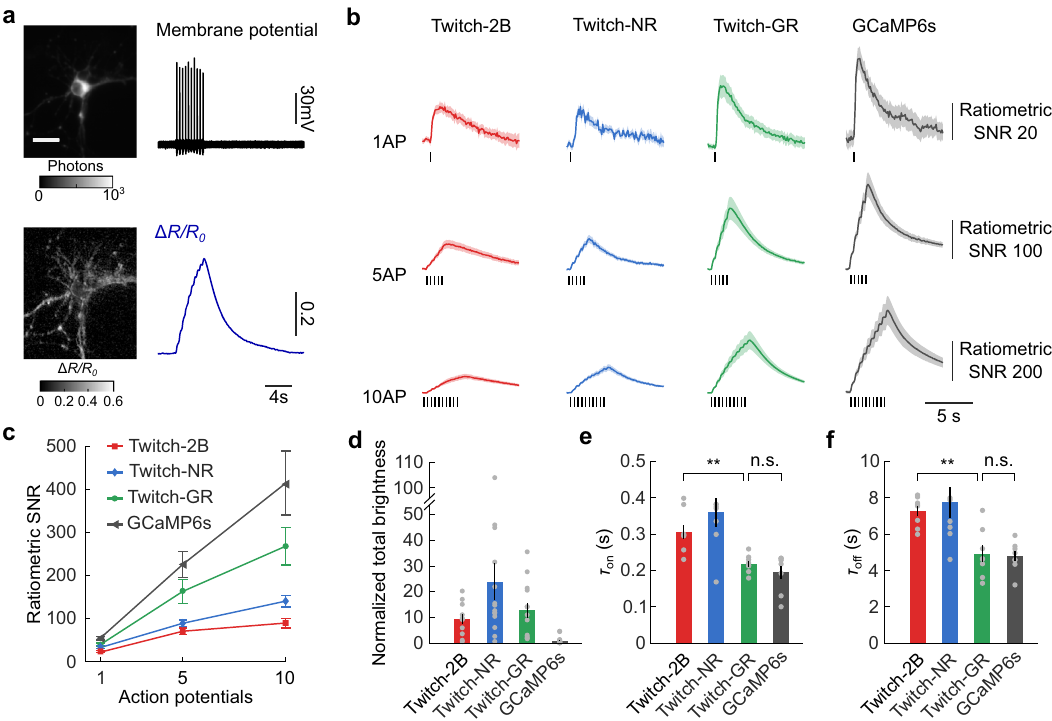
Fig. 3 Twitch-GR and Twitch-NR sensors accurately detected action potentials in cultured hippocampal neurons. a The total brightness of a cultured neuron expressing Twitch-GR ( top left ) along with the spatial Δ R/R response ( bottom left ). The action potentials within the electrical recording of this neuron ( top right ) matched the ratiometric transients within the optical recording of this neuron ( bottom right ). The scale bar is 30 µ m. b The average ratiometric SNR response from neurons expressing Twitch-2B, Twitch-GR, Twitch-NR, and GCaMP6s when fi ring one, fi ve, and ten action potentials, respectively. Solid lines and transparent color regions indicate the mean ± s.e.m. ( n ≥ 10 neurons for each sensor). Black dashes indicate the times of the electrical stimulation. c The relationship between the peak ratiometric SNR and the number of the action potentials from neurons expressing Twitch-2B, Twitch-GR, Twitch-NR, and GCaMP6s (error bars are s.e.m., n ≥ 10 neurons for each sensor). d The total brightness of neurons at rest expressing Twitch- 2B, Twitch-GR, Twitch-NR, and GCaMP6s, all normalized to the mean brightness of GCaMP6s neurons (error bars are s.e.m., n ≥ 10 cells for each sensor). Gray dots indicate individual data points. e The on- and ( f ) off-time constants of Twitch-2B, Twitch-GR, Twitch-NR, and GCaMP6s (error bars are s.e.m.). The on- and off-kinetics of Twitch-GR were signi fi cantly less than those of Twitch-2B (two-sided Wilcoxon rank-sum test, n = 8 cells for each sensor, ** signi fi es p < 0.01, n.s. signi fi es not signi fi cant). Gray dots indicate individual data